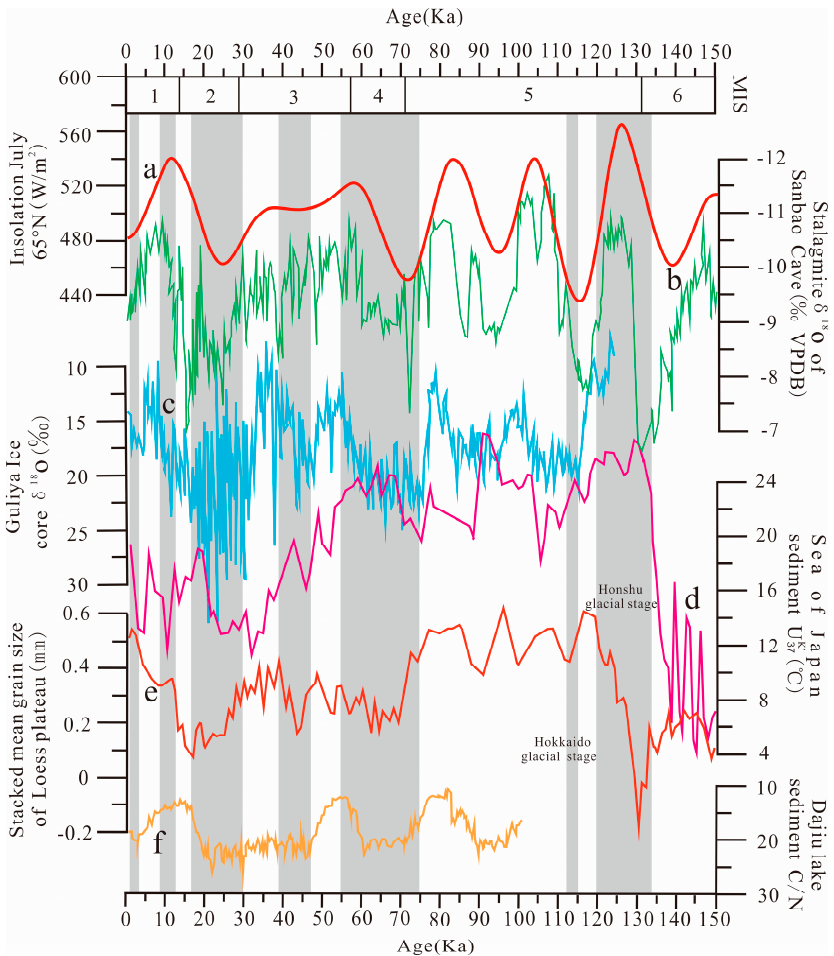
Figure 4. Comparison between glacial stages in the EAM region and the 65°N solar radiation curve, and other proxy records of the EAM. The gray lines represent the dates of mountain glaciations. ( a ) Insolation July 65 °N [96]; ( b ) Stalagmite δ 18 O of Hulu Cave [97]; ( c ) Guliya Ice core δ 18 O [98]; ( d ) Sea of Japan sediment U K ′ 37 [99]; ( e ) Stacked mean grain size of Loess Plateau [100]; ( f ) Dajiu lake sedi- ment C/N [101].